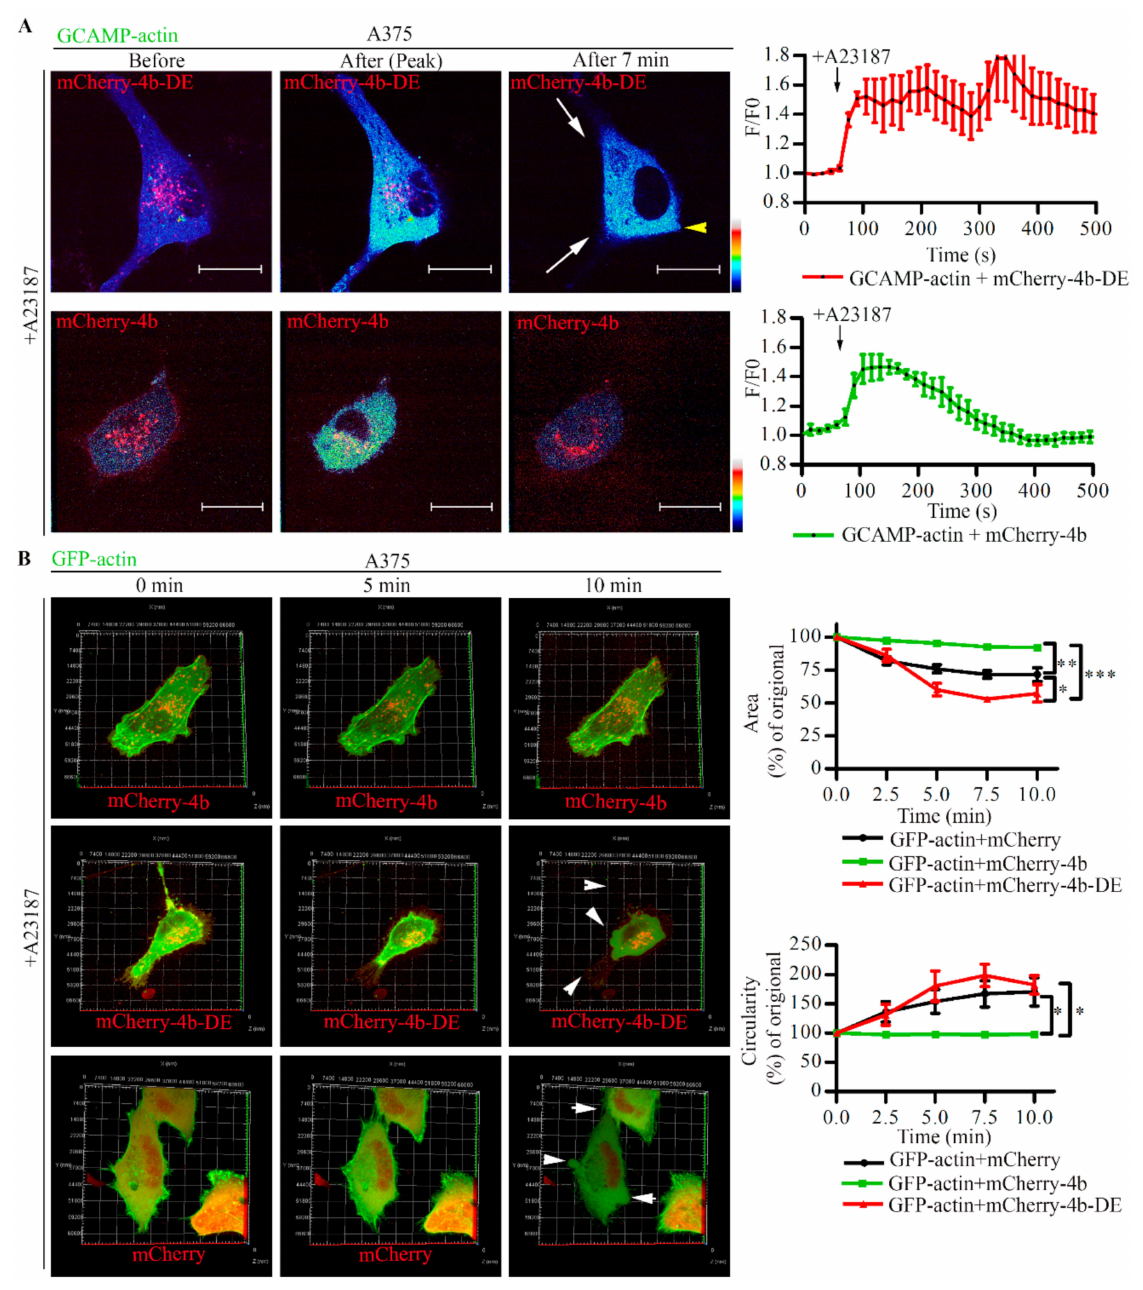
Figure 7. PMCA4b protects F-actin from Ca 2+ -induced degradation. ( A ) Near actin Ca 2+ signal was initiated in A375 cells transiently expressing GCAMP2-actin together with mCherry-PMCA4b or mCherry-PMCA4b-DE by the addition of 2 µ M A23187. GCAMP2 and mCherry signals were recorded every 15 s for 10 min using a spinning-disc confocal microscopy. Confocal microscopy images show cells before, at the peak and 7 min after the addition of A23187, as indicated. Arrowheads show GCAMP2-actin signal retraction. Scale bar, 20 µ m. Graphs represent fluorescence intensity values (F/F0) of the cell shown in ( A ). Error bars represent S.E.M obtained from two independent experiments (two cells analyzed in each, two ROIs per cell). Arrows indicate the addition of A23187. ( B ) 2 µ M A23187 was added to A375 cells expressing GFP-actin together with pmCherry-C1, mCherry-PMCA4b, or mCherry-PMCA4b-DE, and Z-stack images of GFP and mCherry signals were recorded every 15 s for 10 min using a spinning-disc confocal microscope. Three-dimensional confocal images were created by the ZEN 2.3 (blue edition) software, and presented at 0, 5, and 10 min. Arrowheads indicate changes in cell shape. Area and circularity parameters for A375 cells transfected with the same plasmid combinations ( n = 2–3 each) were analyzed by the ImageJ software. Data represent mean ± S.E.M. Significance is calculated for the 10-min time points (* p < 0.05, ** p < 0.01, *** p <